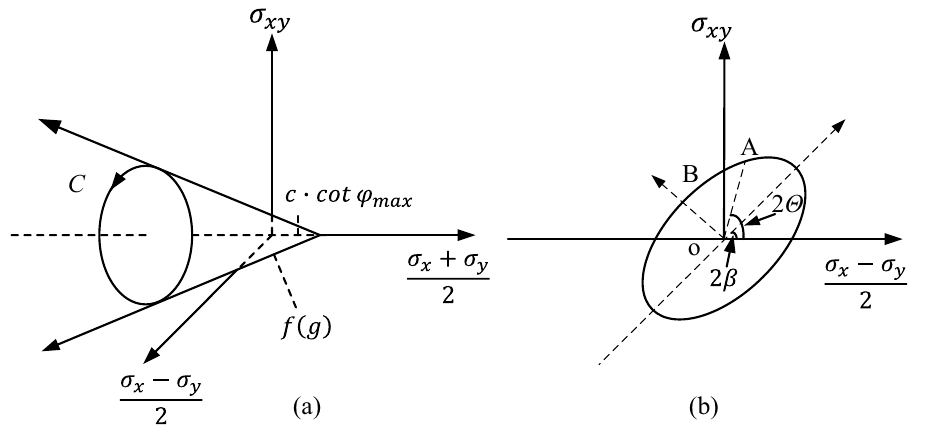
Figure 2. Yield surface in the stress space of ( a ) three dimension; ( b ) ( σ x − σ y )/2, σ xy .